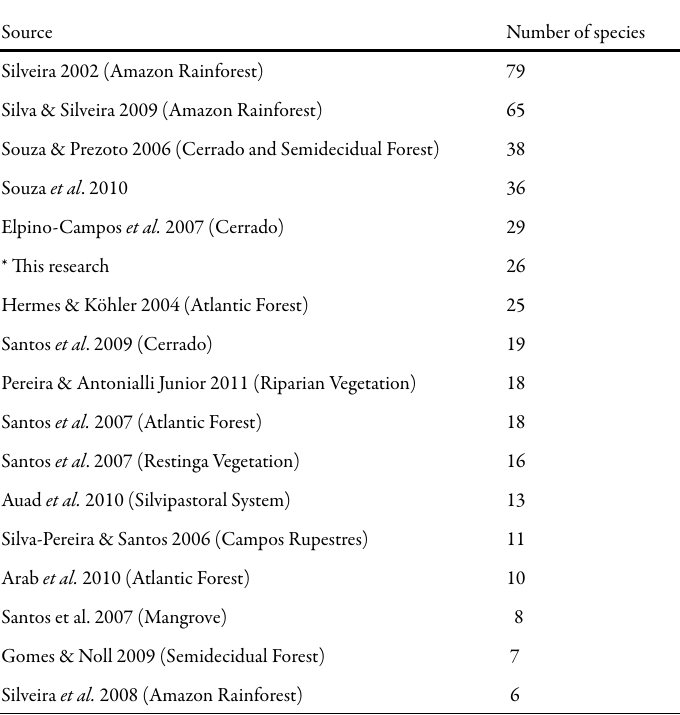
Table 2. Comparison between total number of species in this research (*) and other studies in the literature